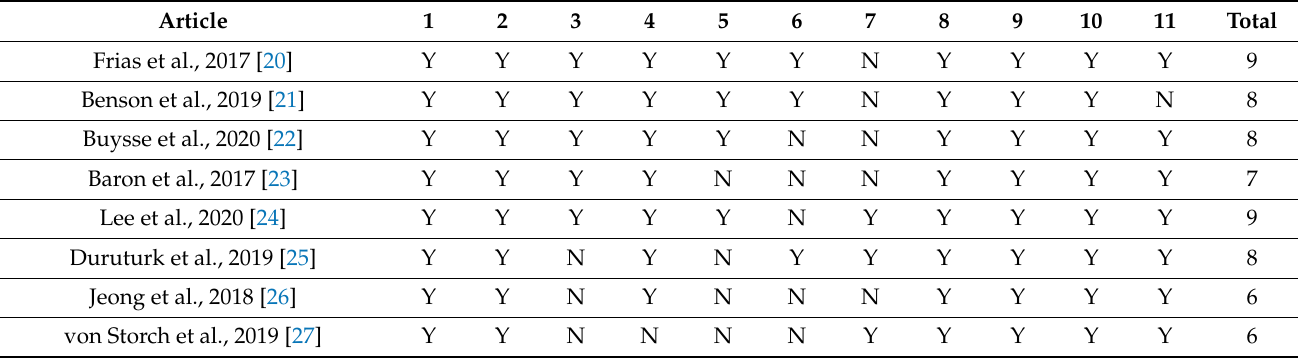
Table 1. Methodological quality of the articles included.